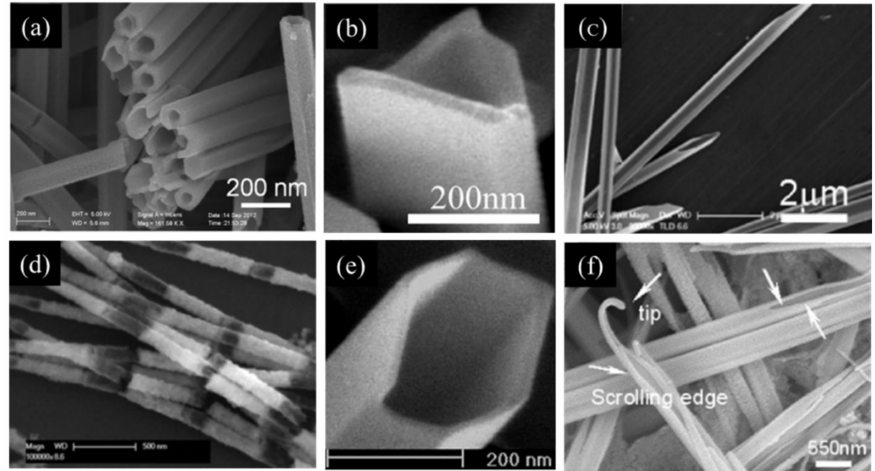
Figure 1. SEM images of Te NTs with different shapes. ( a ) Cylindrical Te NTs. Reprinted with permission from [8]. Copyright 2016, Wiley-VCH Verlag GmbH & Co. KGaA, Weinheim, Germany. ( b ) Individual Te NTs with triangular cross section. Reprinted with permission from [10].